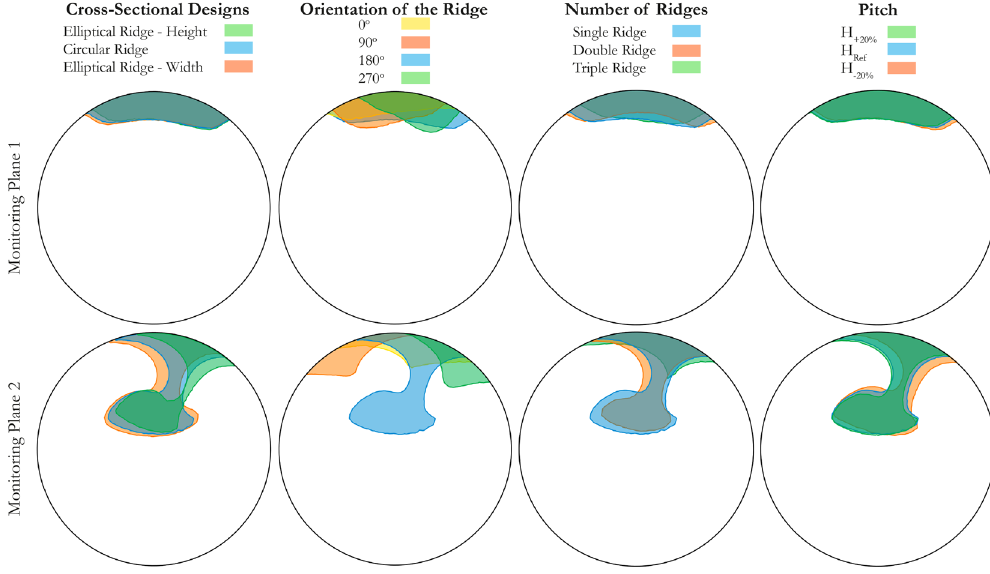
Figure 4. Regions of retrograde flow with different designs at monitoring planes 1 and 2 (monitoring plane 3 is free of